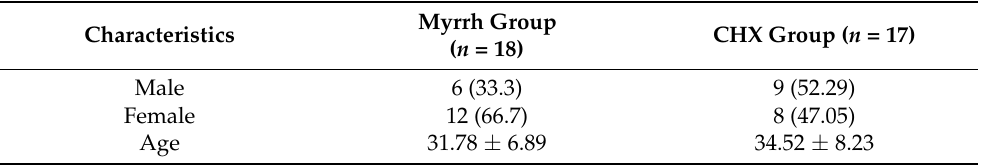
Table 1. Demographic data of study population